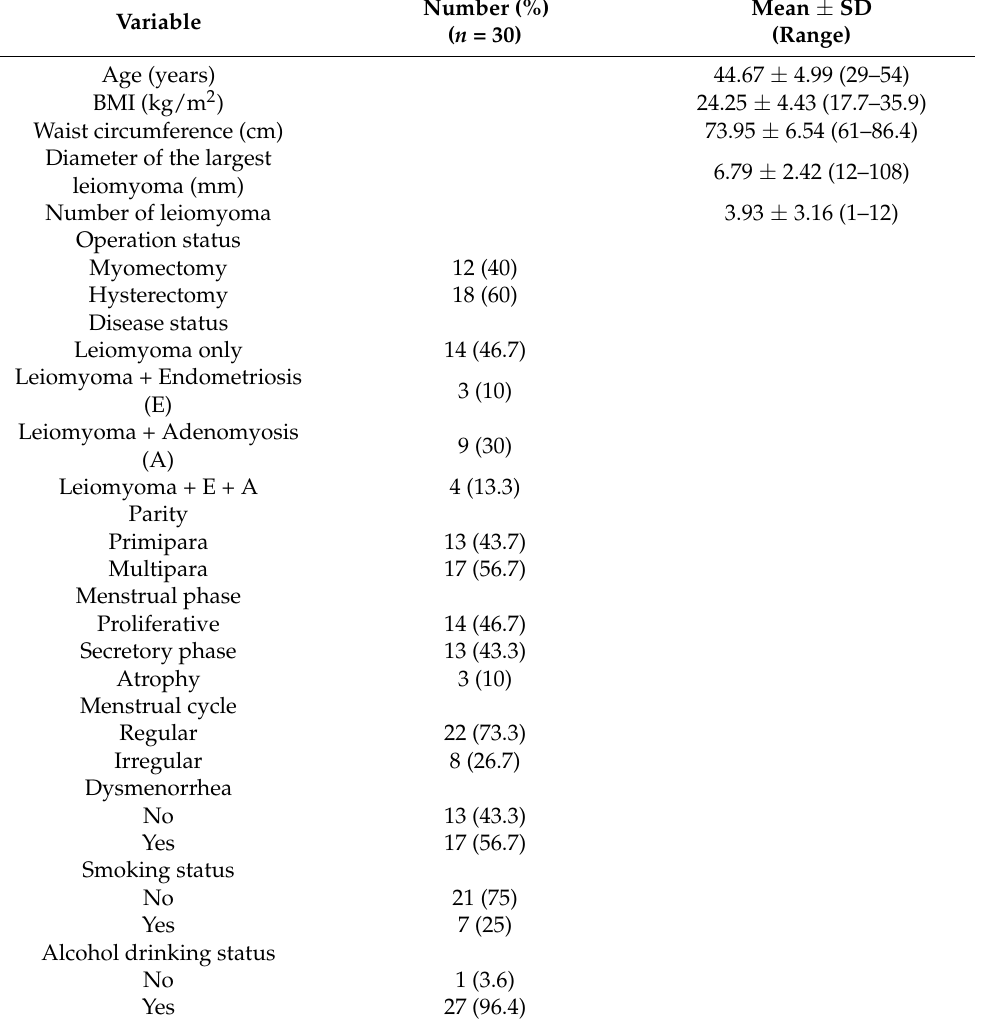
Table 1. Demographic and clinical characteristics of the study